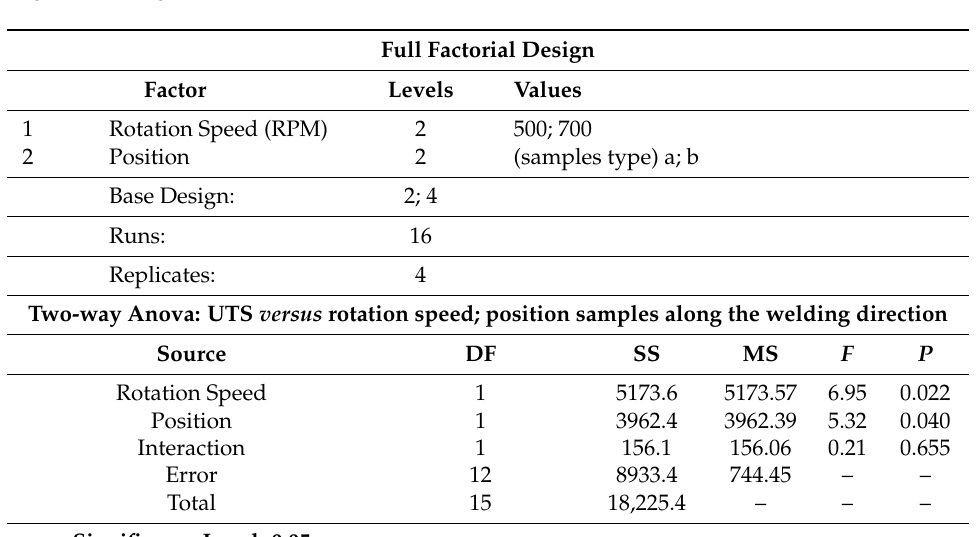
Figure 16. Pareto Graph for the analysis of variance for UTS versus traverse speed, rotation speed, and position of samples along the welding direction. Table 7. General Linear Model: UTS versus traverse speed, rotation speed, and position of samples along the welding